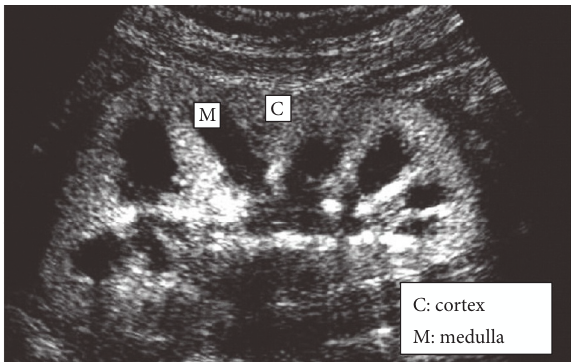
Figure 2: Improving the echogenicity of renal vascular employing